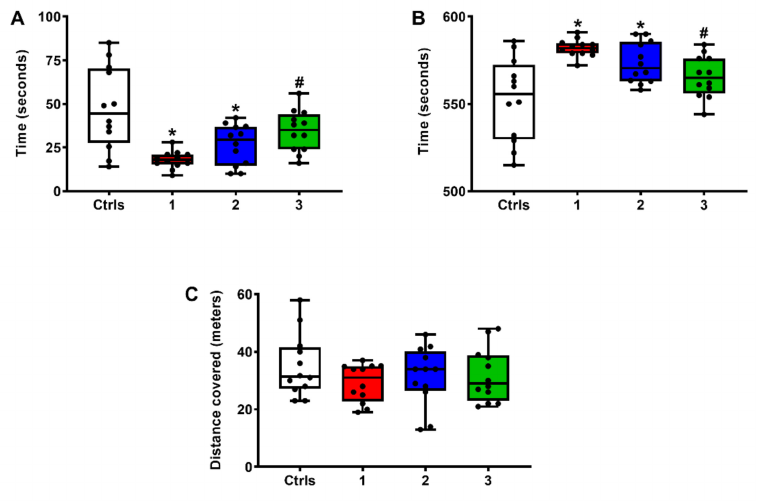
Figure 7. The box plots reporting all data points ( • ), minimum, maximum, median, 25 and 75 percentiles of the time (in seconds) spent in the center ( A ) or in peripheral ( B ) zones and the distance traveled ( C ) in the test arena (open field test, OFT) at 24 h post-injury by rats without and with the s.c. administration of two ILB ® doses (1 and 5 mg/kg b.w.). Ctrls = control sham-operated rats; 1 = sTBI only, sacrificed at 7 days post-injury; 2 = sTBI + 1 mg/kg b.w. ILB ® , sacrificed at 7 days post-injury; 3 = sTBI + 5 mg/kg b.w. ILB ® , sacrificed at 7 days post-injury. * Significantly different from controls, q < 0.05. # Significantly different from untreated sTBI rats, q <